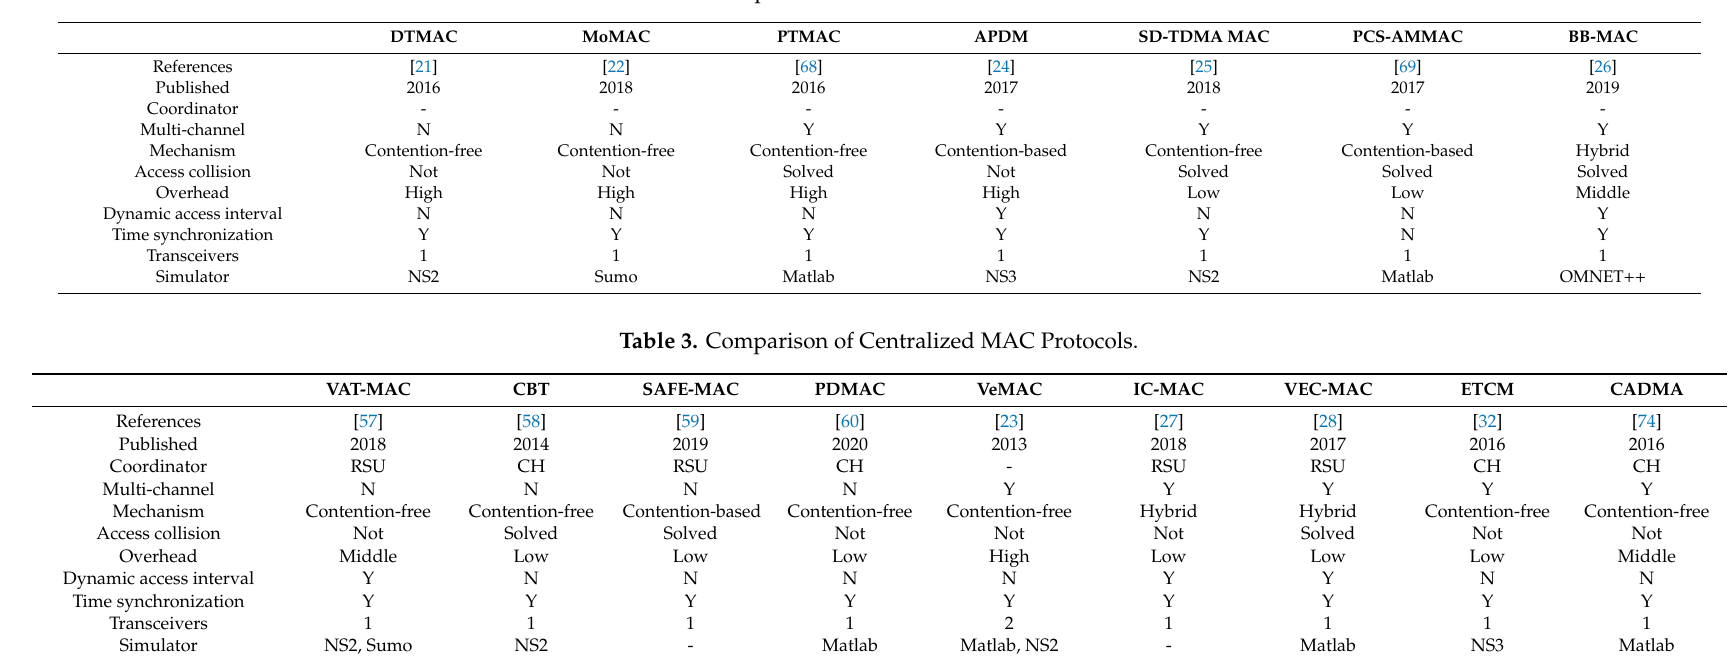
Table 2. Comparison of Distributed MAC Protocols.